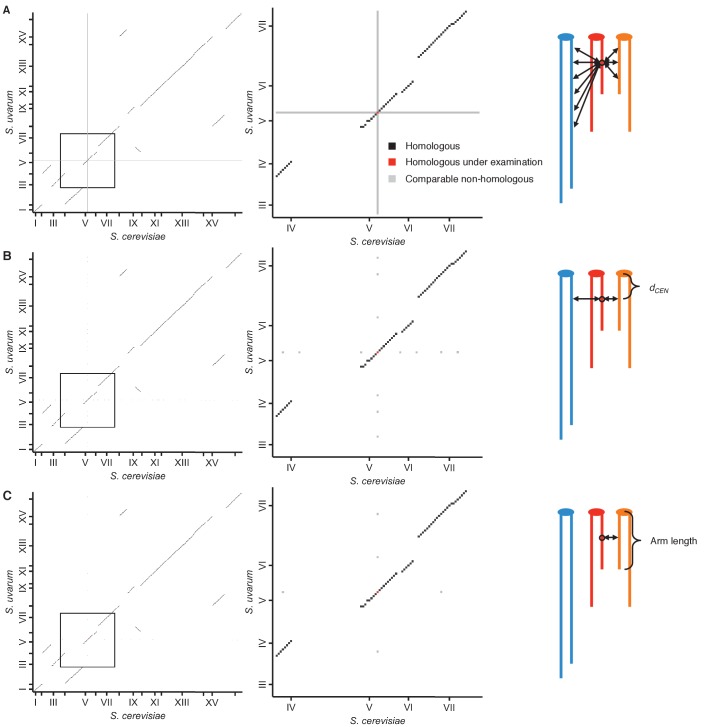
Schematic of homolog proximity analysis.Representation of how homologous interactions (black squares) were compared to various subsets of nonhomologous interactions (grey squares), either including all interactions with either homologous locus (red squares) (A), restricted to interactions with loci at a similar centromeric distance, or dCEN (same number of 32 kb bins) (B), or restricted to interactions with loci at a similar centromeric distance and on a chromosome arm of similar length (within 25%) (C). Left panels show all interactions between the S. cerevisiae and S. uvarum genomes; middle panels show enlarged view of the area outlined in the left panels. Tick marks indicate centromere positions. Right panels represent the nonhomologous interactions being used for comparison; different colors represent nonhomologous chromosomes, and double-headed arrows represent interactions with the locus of interest (circled).